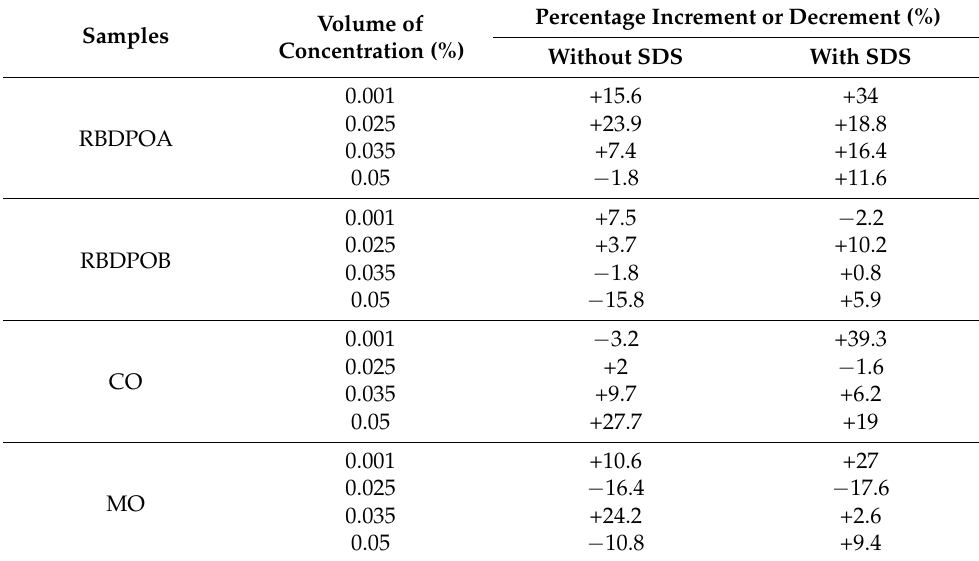
Table 1. Percentages of PDIV increment or decrement for RBDPO, CO and MO Al 2 O 3 based nanofluids.